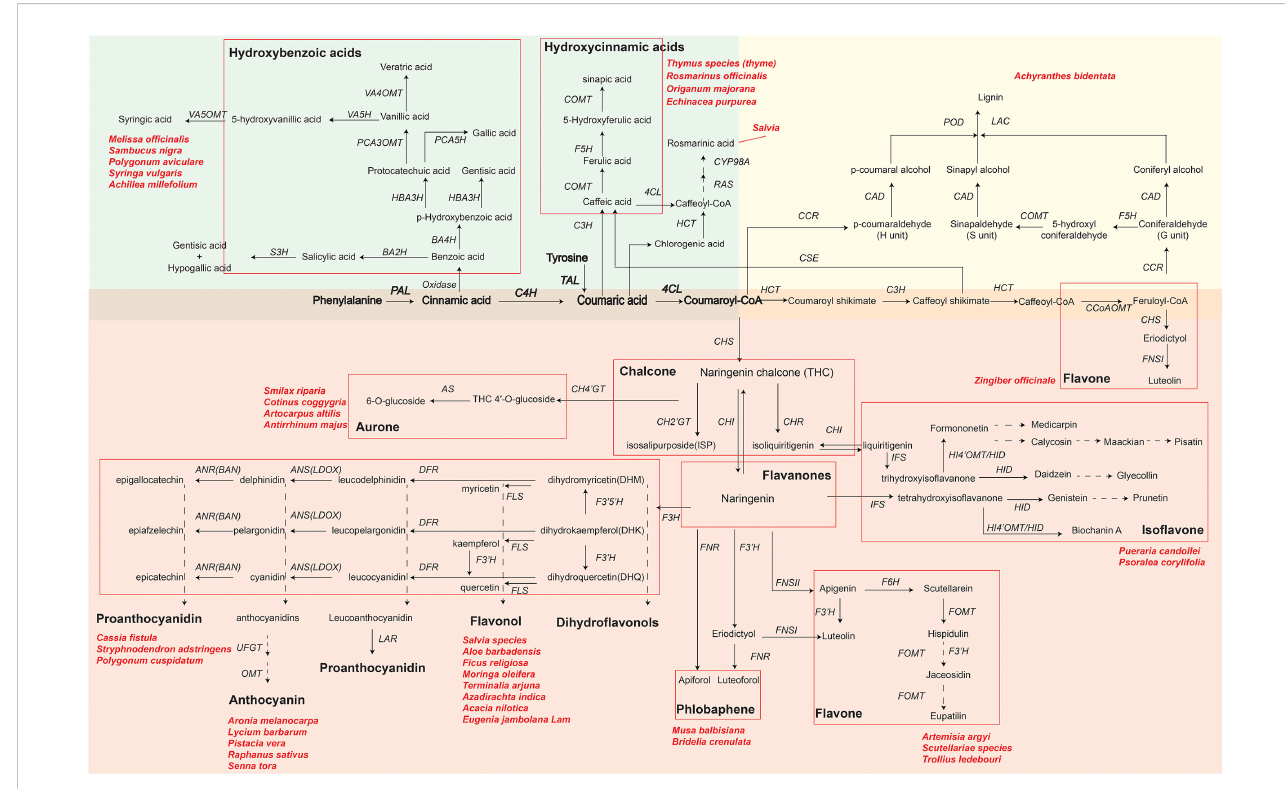
FIGURE 2 Key genes and metabolites of three phenolics compounds biosynthesis pathways in plants. The green, yellow and red background areas represent the biosynthetic pathways of phenolic acids, lignin and fl avonoids, respectively. Bolded metabolites and genes represent the beginning of henylpropanoid pathway shared by phenolics compounds biosynthesis. Different fl avonoids are indicated by black bold font and grouped by red rectangular boxes in each pathway. Key genes in biosynthesis pathways are in italics: PAL , phenylalanine ammonialyase; C4H , cinnamic acid 4-hydroxylase; 4CL , 4- coumarate-CoA ligase; HCT , hydroxycinnamoyl CoA shikimate hydroxycinnamoyl transferase; RAS , rosmarinic acid synthase; CYP98A , cytochrome P450-dependent monooxygenase; C3H , p -coumarate 3-hydroxylase; CHS , chalcone synthase; CH4 ’ GT , chalcone 4 ’ -O-glucosyltransferase; CH2 ’ GT , chalcone 2 ′ -glucosyltransferase; AS , aureusidin synthase; CHR , chalcone reductase; CHI , chalcone fl avanone isomerase; IFS , iso fl avone synthase; F3 ′ H , favonoid 3 ′ hydroxylase; FNS ( FNSI and FNSII ), fl avone synthase; F6H , fl avanone-6-hydroxylase; FOMT , fl avonoid O-methyltransferase; HI4 ’ OMT , hydroxyiso fl avone 4 ’ -O-methyltransferase; HID , hydroxyiso fl avanone dehydratase; DFR , dihydro fl avonol 4-reductase; F3H , favanone 3-hydroxylase; F3 ’ 5 ’ H , fl avonoid-3 ′ ,5 ′ -hydroxylase; FLS , fl avonol synthase; ANS , anthocyanidin synthase ( LDOX , leucoanthocyanidin dioxygenase); ANR , anthocyanidin reductase; LAR , leucoanthocyanidin reductase; UFGT , UDP glucose: fl avonoid 3-O-glycosyltranferase; OMT , O-methyltransferase; CCoAOMT , caffeoyl- CoA O-methyltransferase; F5H , ferulate 5-hydroxylase; CSE , caffeoyl shikimate esterase; COMT , caffeic acid O-methyltransferase; CCR , cinnamoyl-CoA reductase; CAD , cinnamyl alcohol dehydrogenase; LAC , laccase; POD , peroxidase; TAL , tyrosine ammonia lyase; BA2H , benzoic acid 2-hydroxylase; S3H , salicylic acid 3-hydroxylase; BA4H , benzoic acid 4-hydroxylase; HBA3H , p-hydroxybenzoic acid 3-hydroxylase; PCA5H , protocatechuic acid 5- hydroxylase; PCA3OMT , protocatechuic acid 3-O-methyltransferase; VA4OMT , vanillic acid 4-O-methyltransferase; VA5H , vanillic acid 5-hydroxylase; VA5OMT , vanillic acid 5-O-methyltransferase. Naringenin chalcone and naringenin in a larger font are key primarily intermediate metabolite in fl avonoid biosynthesis. Dashed arrows indicate that some unknown enzymes are involved in these processes. Scienti fi c names are representative medicinal plants, which are exploited by various pharmaceutical companies to produce phenolics